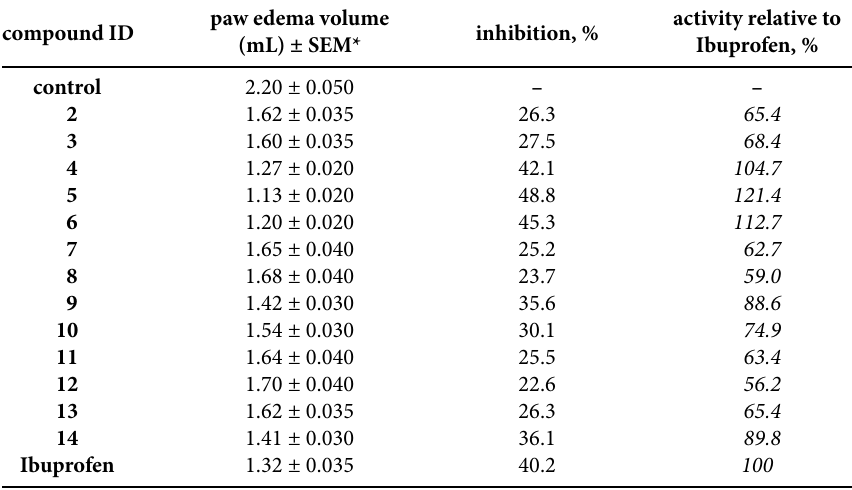
Table 1. Anti-inflammatory effect of thiazolo[4,5- b ]pyridine-2-ones on carrageenan-induced rat paw edema (ml) in vivo evaluation and % of protection from inflammation compound